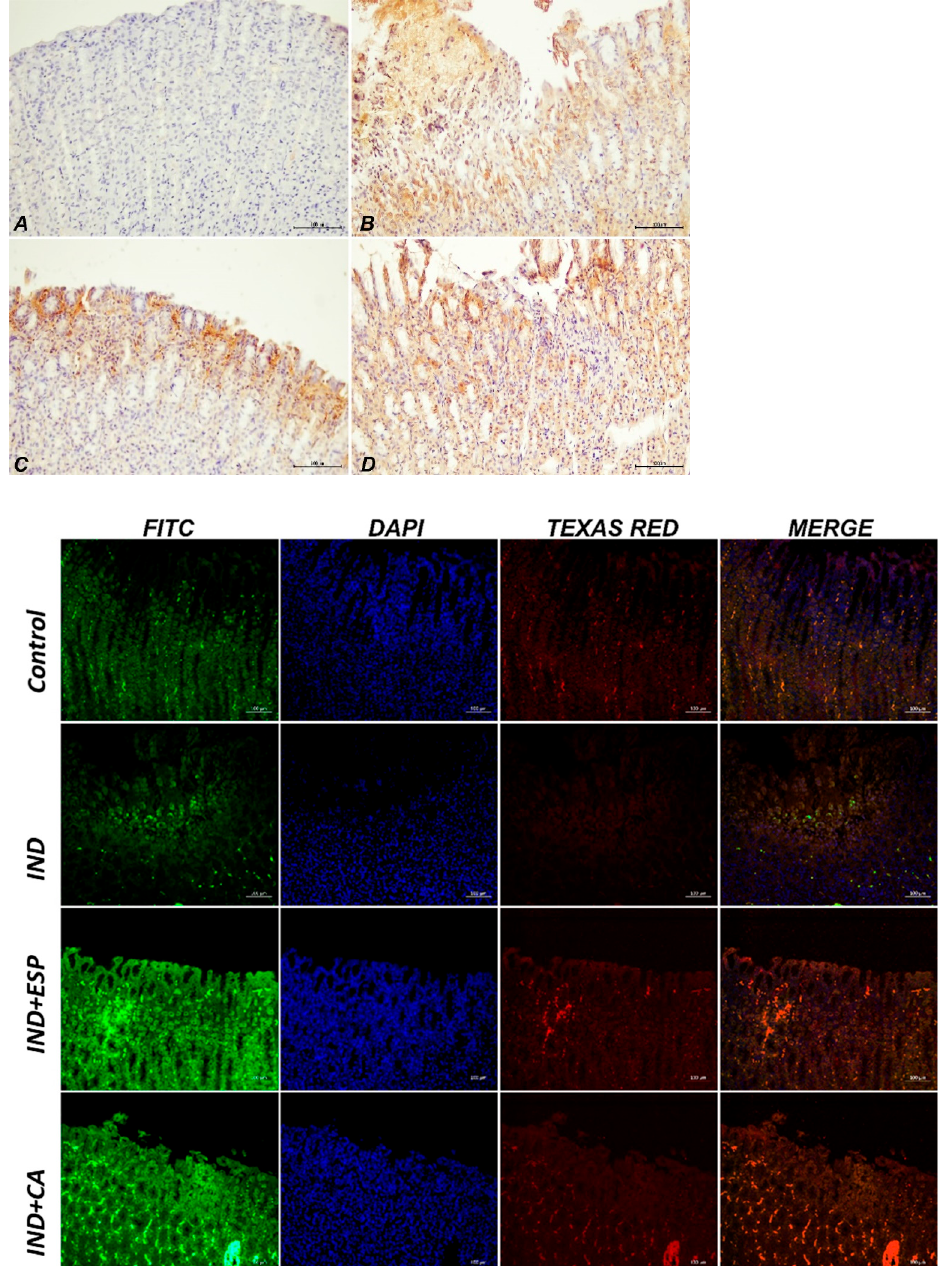
Figure 4. Gastric tissue, Nrf-2 expression (FITC), HO-1 Expression (Texas Red), D-IF, 4 ′ ,6-Diamidino-2-Phenylindole (DAPI), Fluorescein Isothiocyanate (FITC), IND: Indomethacin, ESP: Esomeprazole, CA: Carnosic acid. Bar: 100 μ m. Table 3 . Effects of CA on IND-induced TNF- α , Nrf-2 and HO-1 expressions.